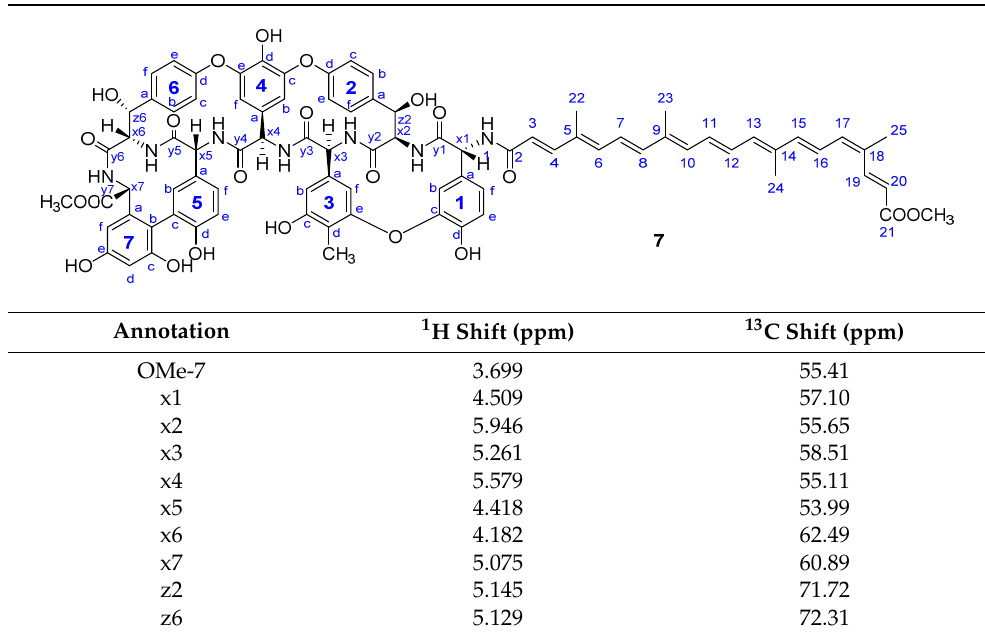
Table 7. Cont. Table 7. NMR data of 7